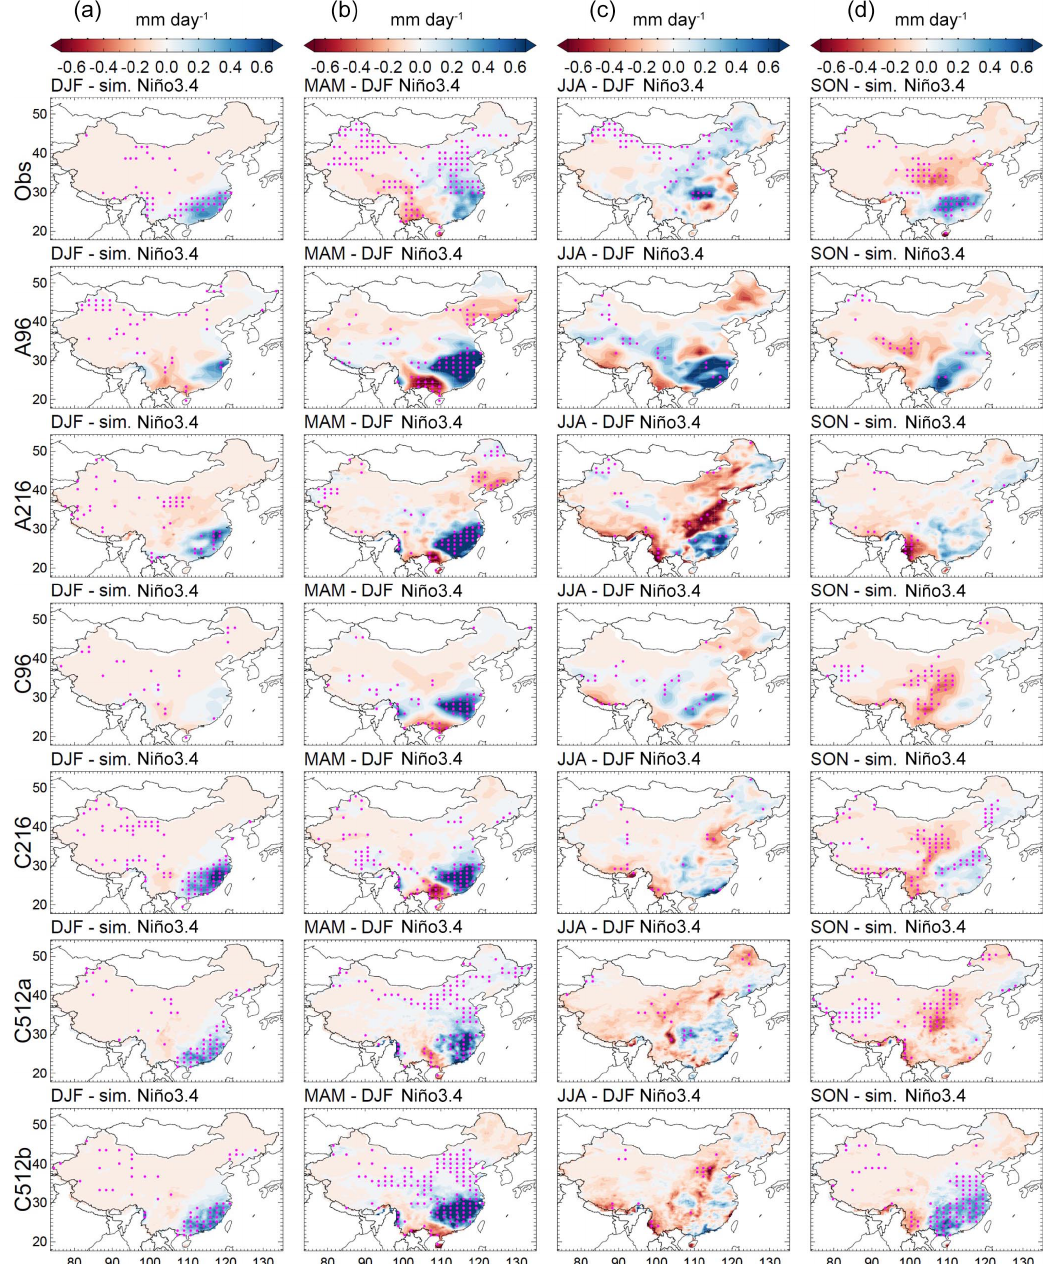
Figure 4. Regression of DJF precipitation against observed or simulated DJF Niño3.4 (a) ; lagged regression of MAM precipitation against preceding DJF Niño3.4 (b) ; lagged regression of JJA precipitation against preceding DJF Niño3.4 (c) ; regression of SON precipitation against SON Niño3.4 (d) . Stippling indicates confidence levels exceeding